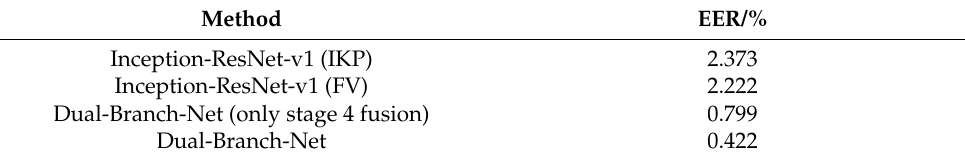
Figure 6. ROC curves of ablation experiment results. Table 3. Results of ablation